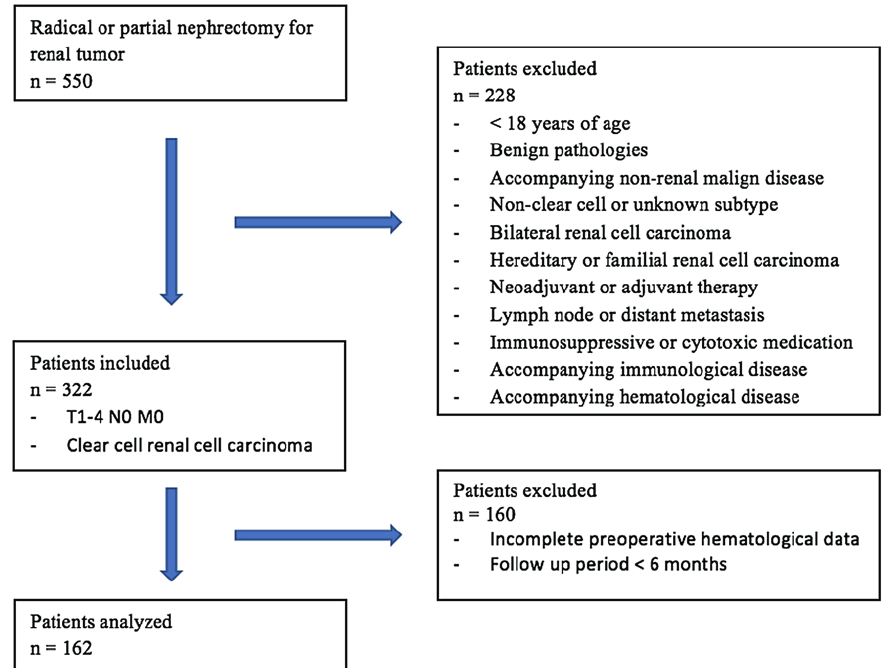
Figure 1 - Flow chart of patients who met study inclusion / exclusion